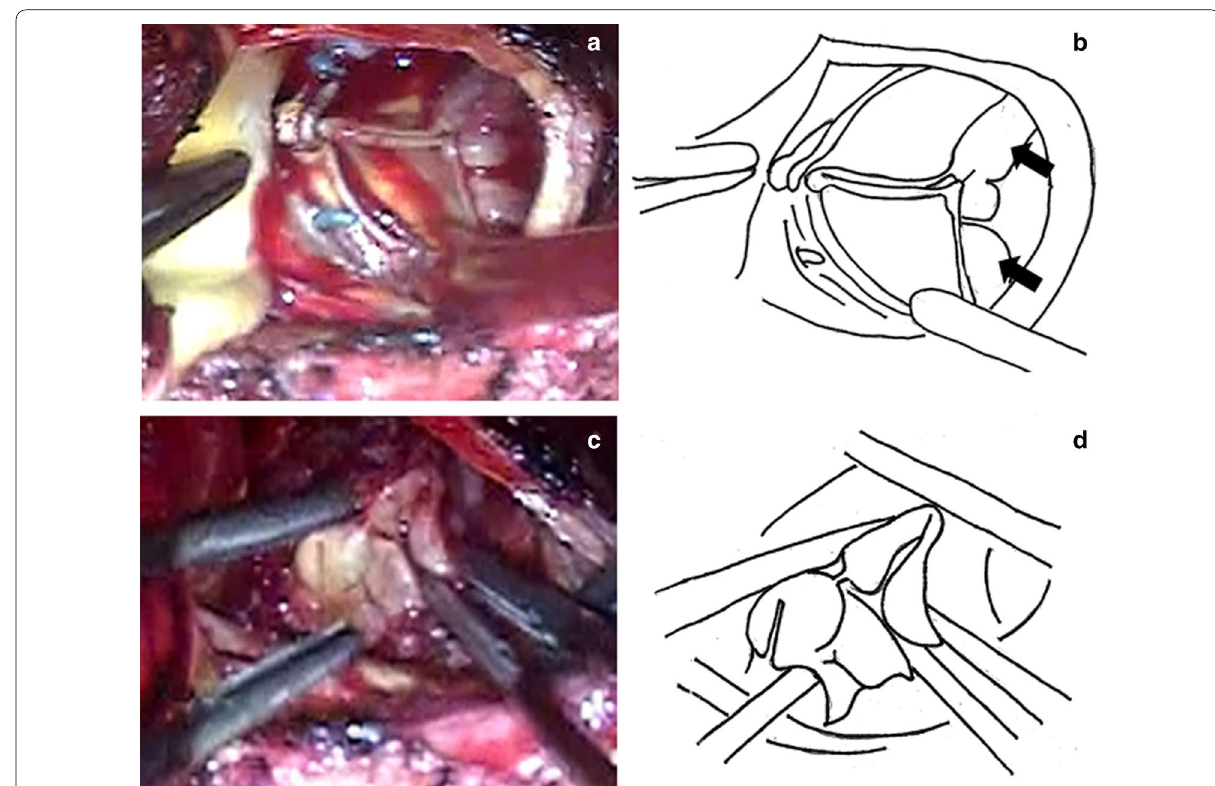
Fig. 2 a , b The prosthetic valve covered with vegetation (arrow). c , d Large vegetation covers the outflow